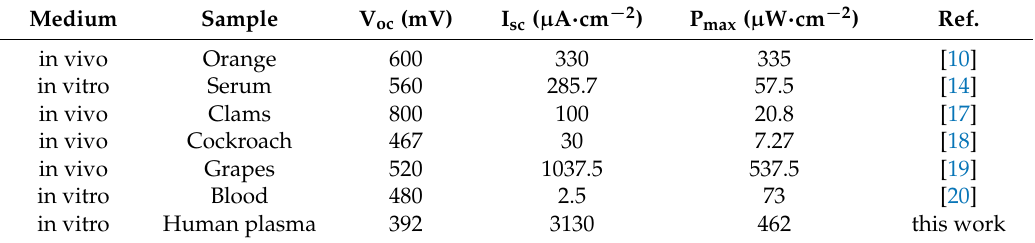
Table 1. Performance of enzymatic glucose biofuel cell under in vitro and in vivo environments.